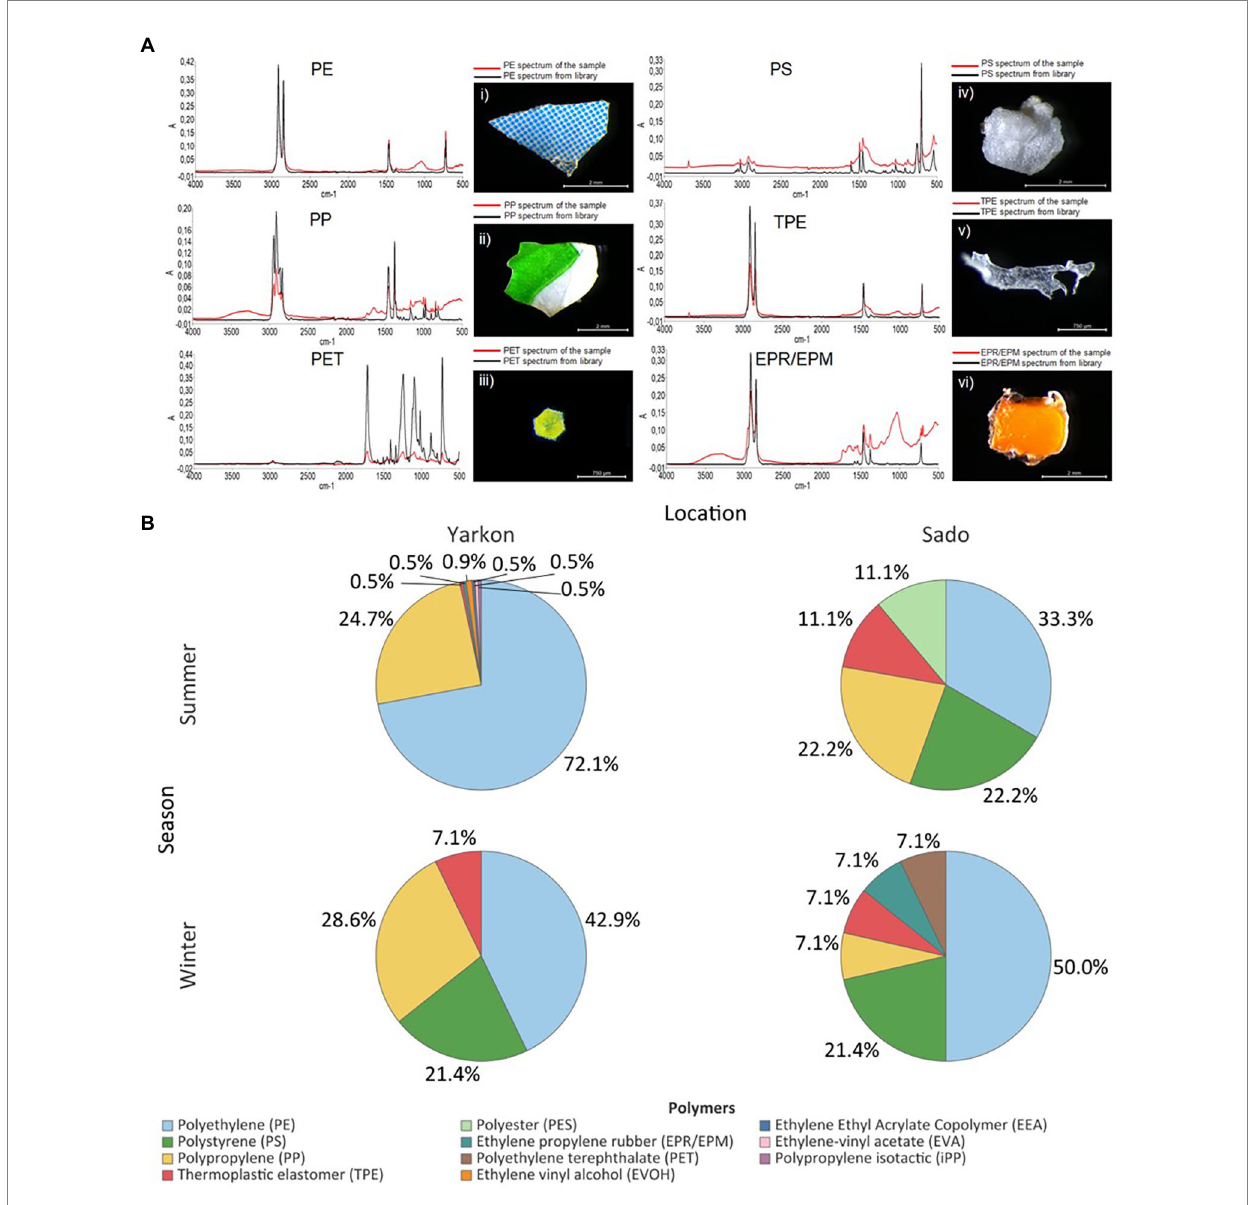
FIGURE 3 Microplastic polymer composition. (A) Infrared spectra of the most common polymers from Yarkon and Sado (red) and their reference spectra (black): (i) blue and white fragment with PE spectrum (Yarkon summer); (ii) white and green fragment (Yarkon summer) with PP spectrum; (iii) iridescent glitter particle with PET spectrum (Sado winter); (iv) a foam particle with PS spectrum (Sado summer); (v) TPE fragment and its spectrum (Sado summer); (vi) an orange fragment with EPR/EPM spectrum (Yarkon summer). The y-axis corresponds to absorbance–A, and the x -axis to wavenumber (cm- 1 ). (B) Polymers composition in Yarkon and Sado according to season. Results are expressed in % of polymers relatively to the total microplastics